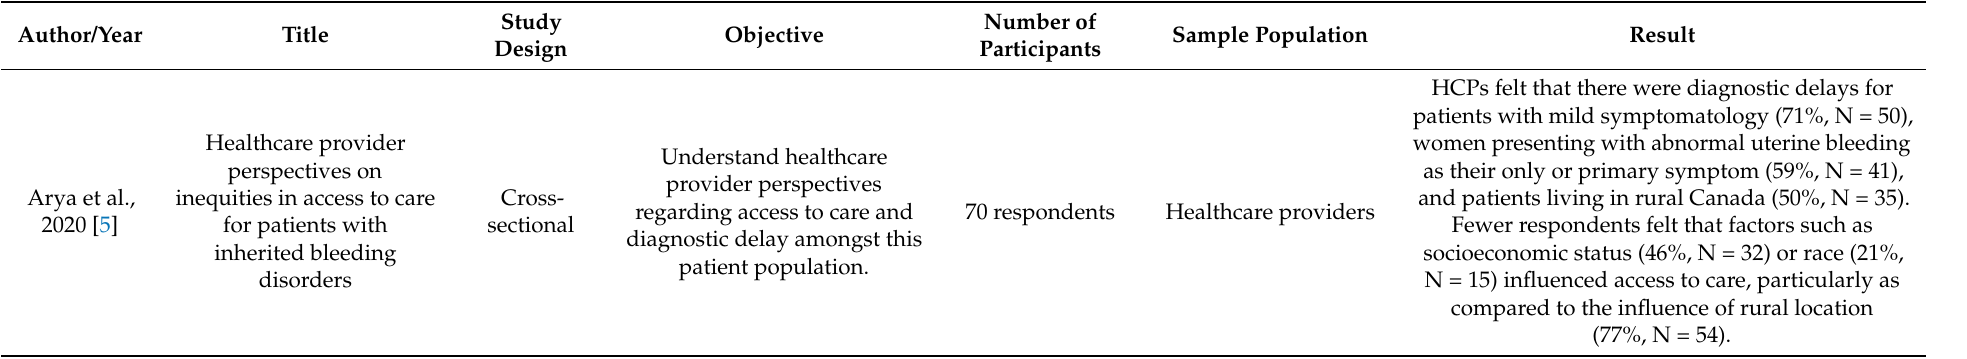
Table 6. Summary of articles found focused on Health Care